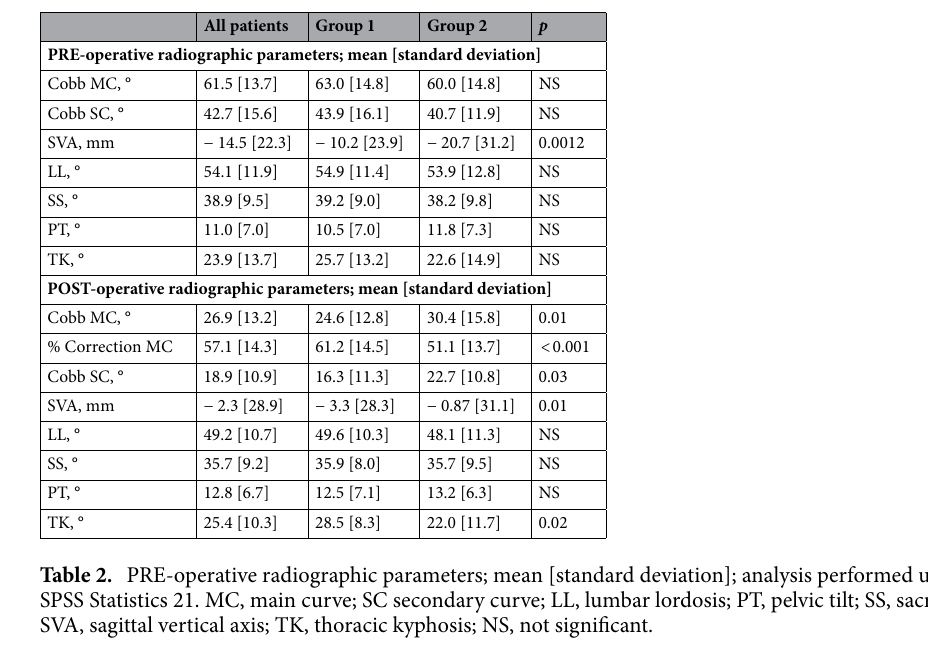
All patients Group 1 Group 2